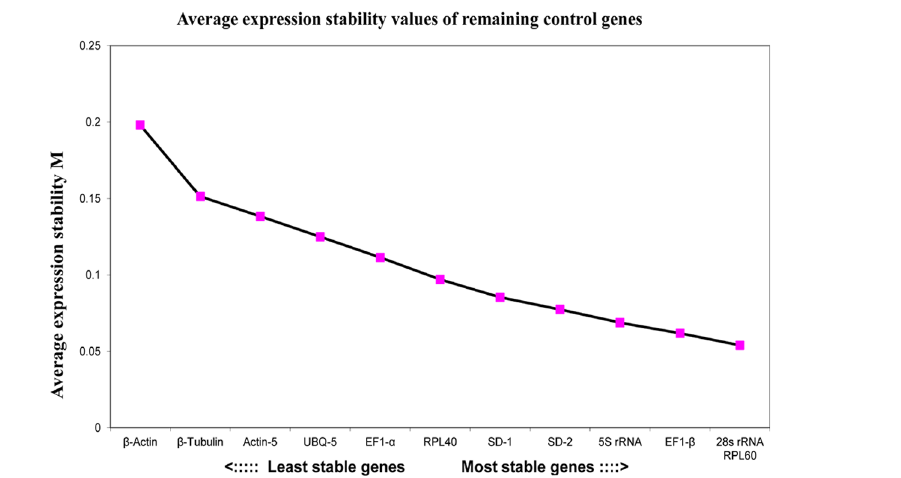
Fig 3. Expression stability of 12 candidate reference genes calculated by geNorm.